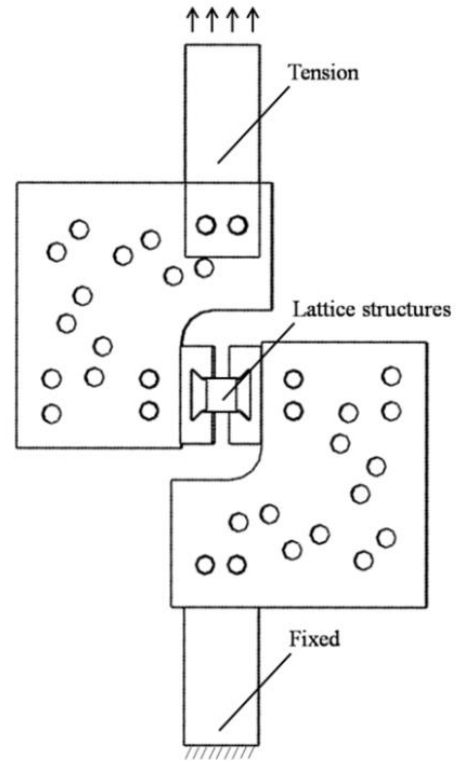
Figure 11. Principle of lattice structures shear test.